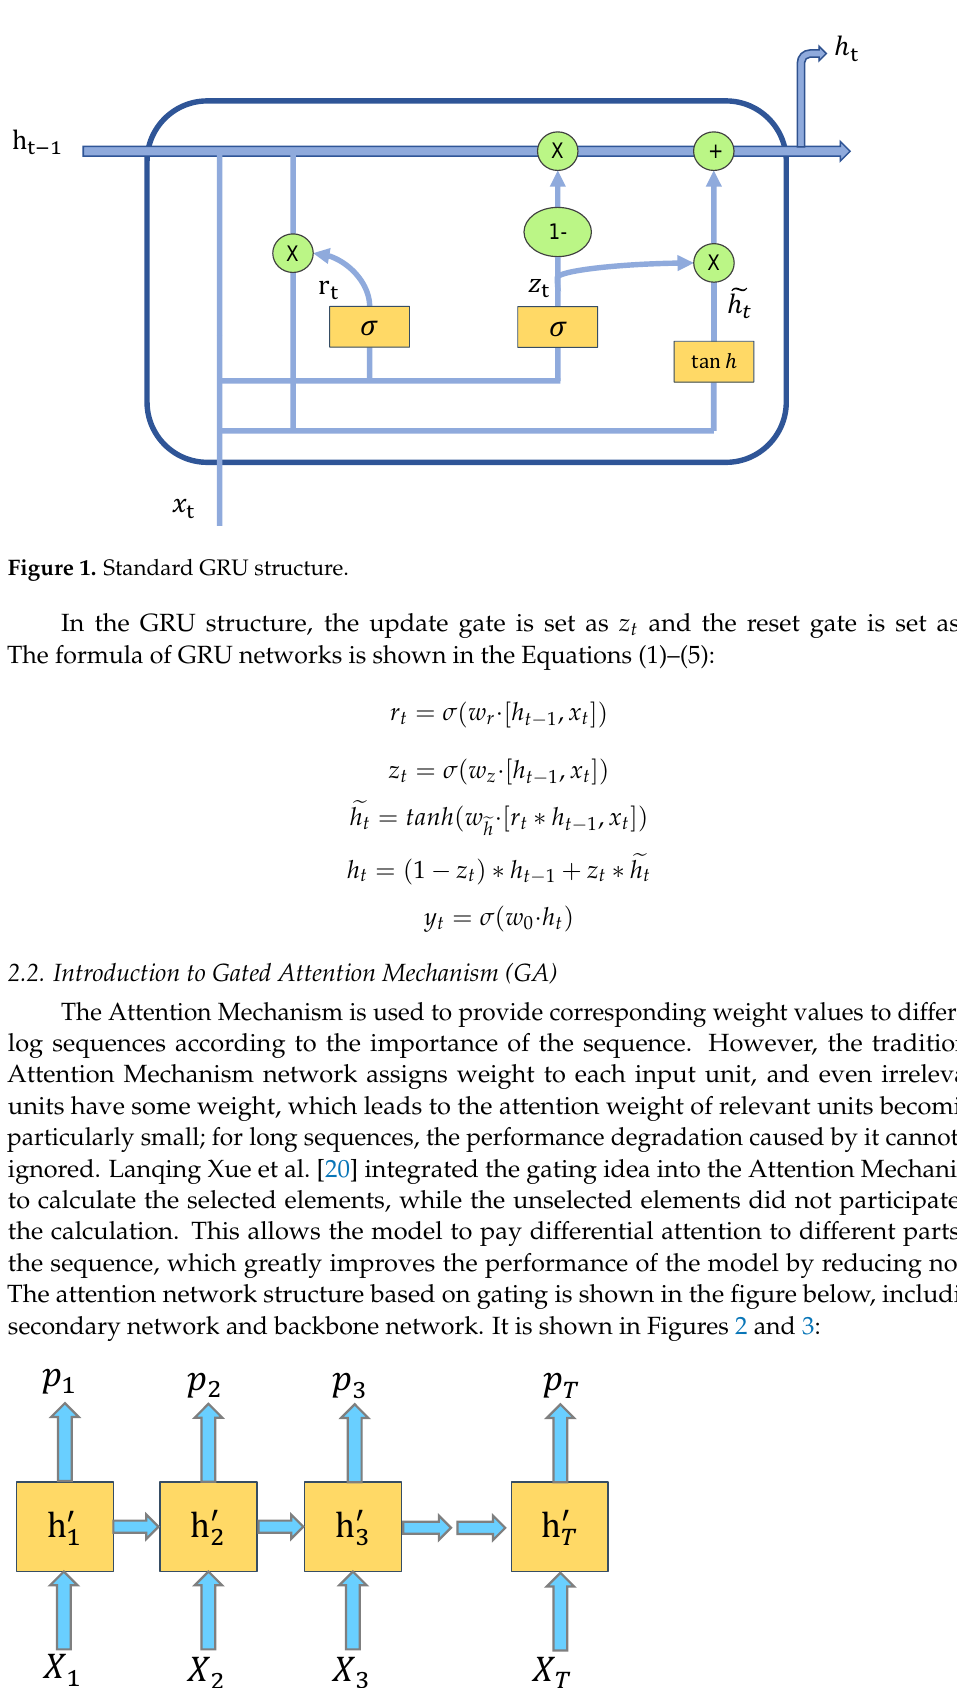
Figure 1. Standard GRU structure.